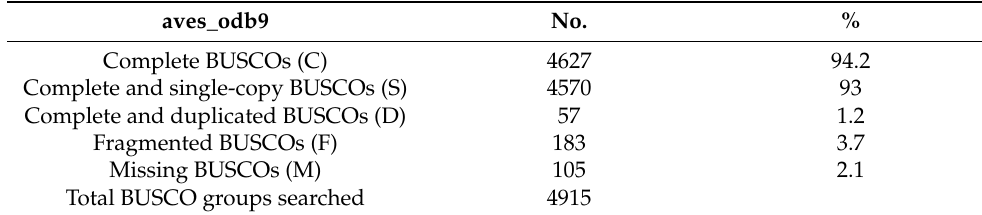
Table 2. Assessment of the Macronectes giganteus genome assembly via BUSCO.